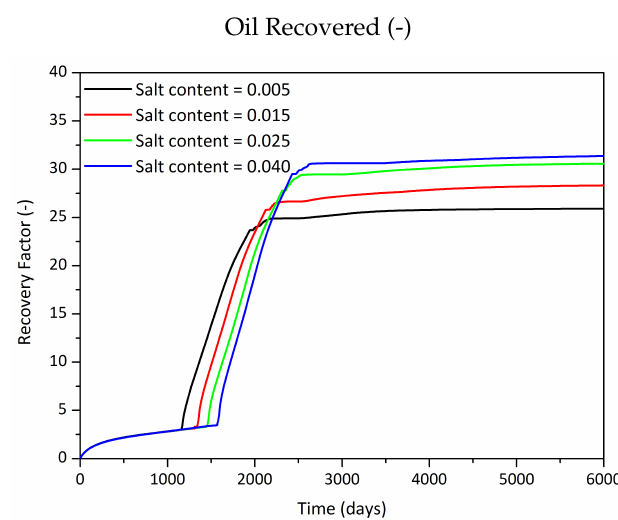
Figure 17. Oil recovered as a function of time for different initial salt concentrations in the reservoir.